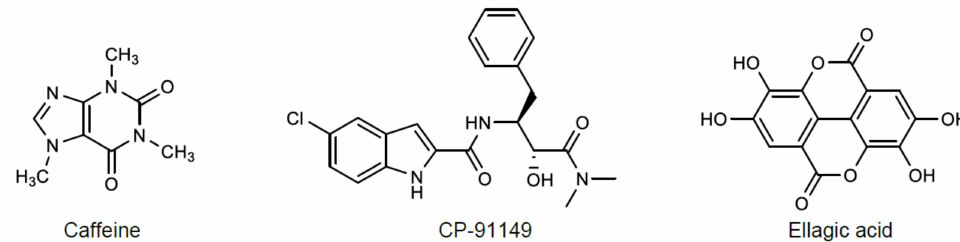
Figure 3. Chemical structures of some known inhibitors of GP activity: caffeine, CP-91149, and ellagic acid.